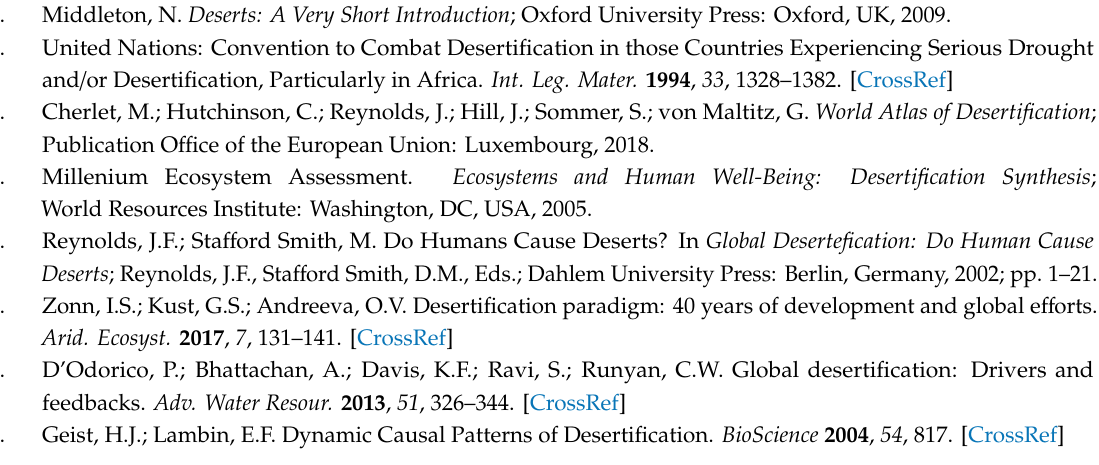
Figure S1: Typical landscape of the Desert of Tabernas where the contrast between the steepest and bare hillsides and the presence of esparto grass (Macrochloa tenacissima) in more stable and less steep hillslopes can be appreciated. (Source: J. Martinez-Valderrama); Figure S2: Traditional dryland olive groves benefiting from the higher humidity naturally found in the “ramblas”; Figure S3: Traditional dryland olive groves on the edge of cultivation terraces; Figure S4: Satellite observations show an intensification of the olive grove. (A) In 2013 (image above) the whole area was covered by olive trees under intensive irrigation. (B) In 2019 (lower image) the lower right plot has been replaced by super-intensive olive grove; Figure S5: New land in preparation for planting olive